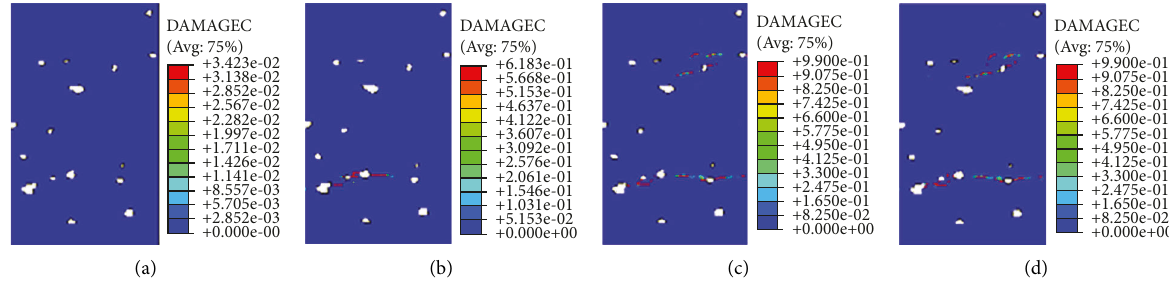
Figure 20: Damage failure graphs under different loading displacement. (a) s � 0.002mm. (b) s � 0.015mm. (c) s � 0.016mm. (d) s � 0.12mm.